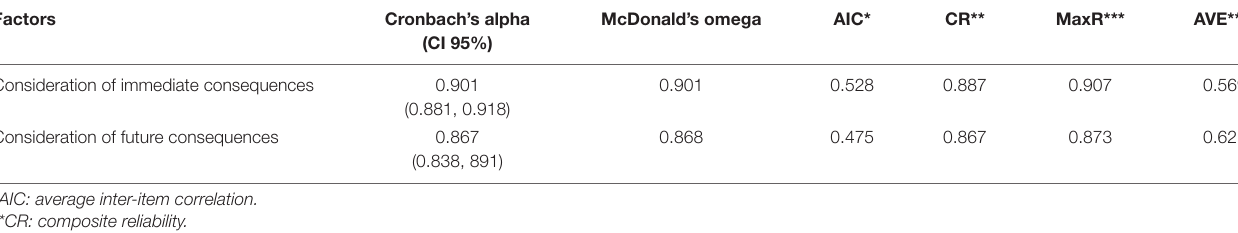
TABLE 3 | Construct reliability and convergent validity of Malaysian version of CFC scale ( N = 264).